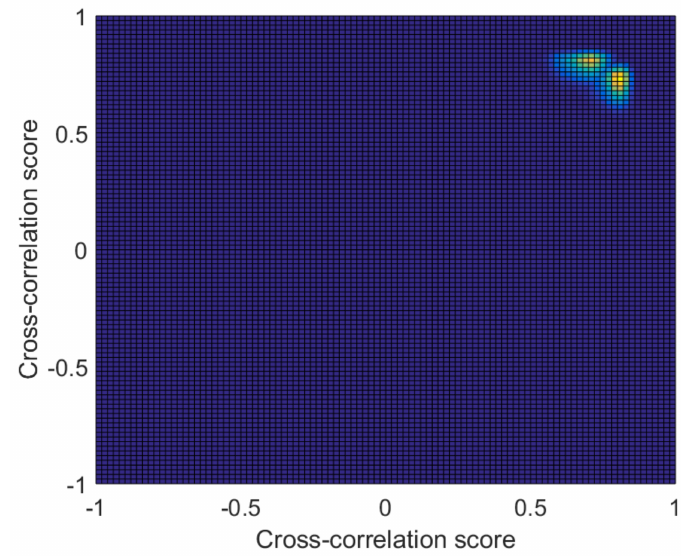
Figure 10. Joint distributions of LMS-filters extracted features (cross-correlation scores) for horizontal and vertical orientation in the Cx channel, p ( x 0 ◦ , x 90 ◦ | 0 ◦ ,0 ◦ ) and p ( x 0 ◦ , x 90 ◦ | 90 ◦ ,90 ◦ )